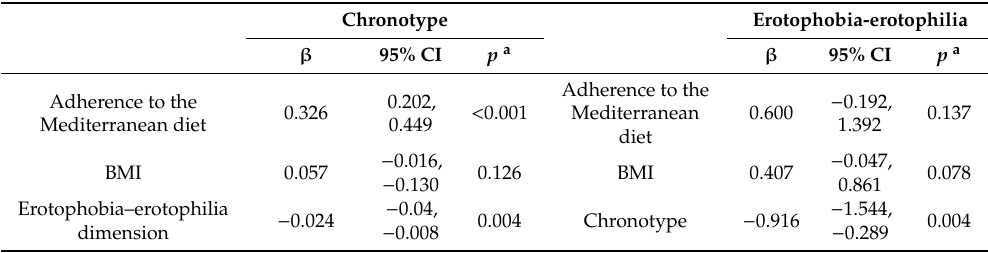
Table 3. Associations between adherence to the Mediterranean diet, the erotophobia–erotophilia dimension, and